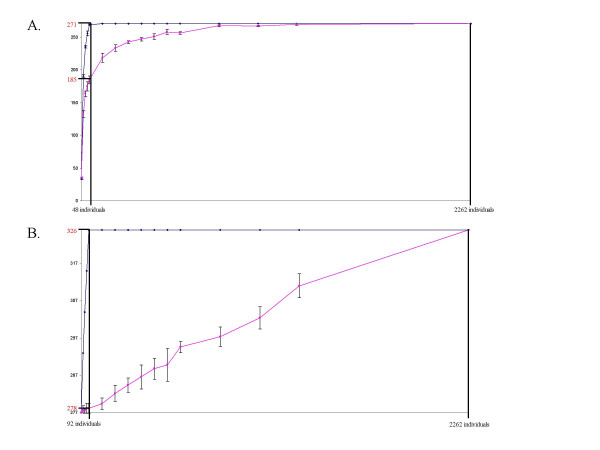
Redundancy curves obtained using MSTRAT software. Redundancy curves with standard deviation obtained using MSTRAT software (five independent samplings). Determination of the optimal size allowed the capture of all alleles of the original sample. A. For the 271 alleles of the restricted Vassal collection using the M-method (blue dot) and random sampling method (pink dot). B. For the 326 alleles of the Vassal collection using the G-48 core as core using the M-method (blue dot) and random sampling method (pink dot).